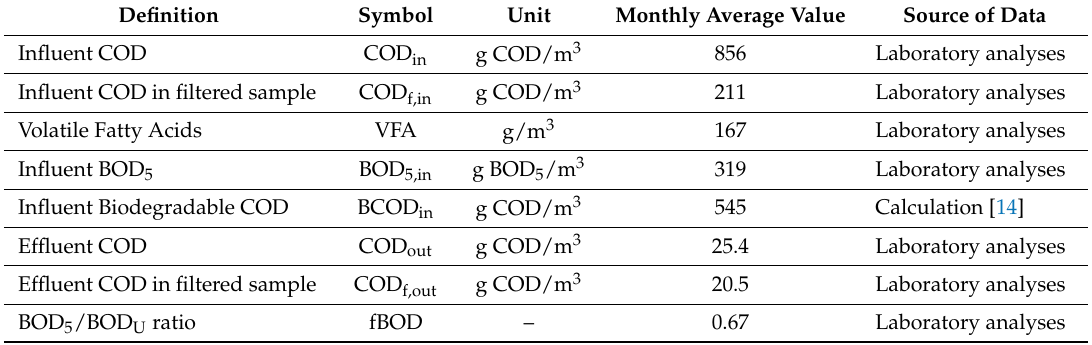
Table 1. Characteristics of the influent wastewater during studied periods at Debogorze WWTP.